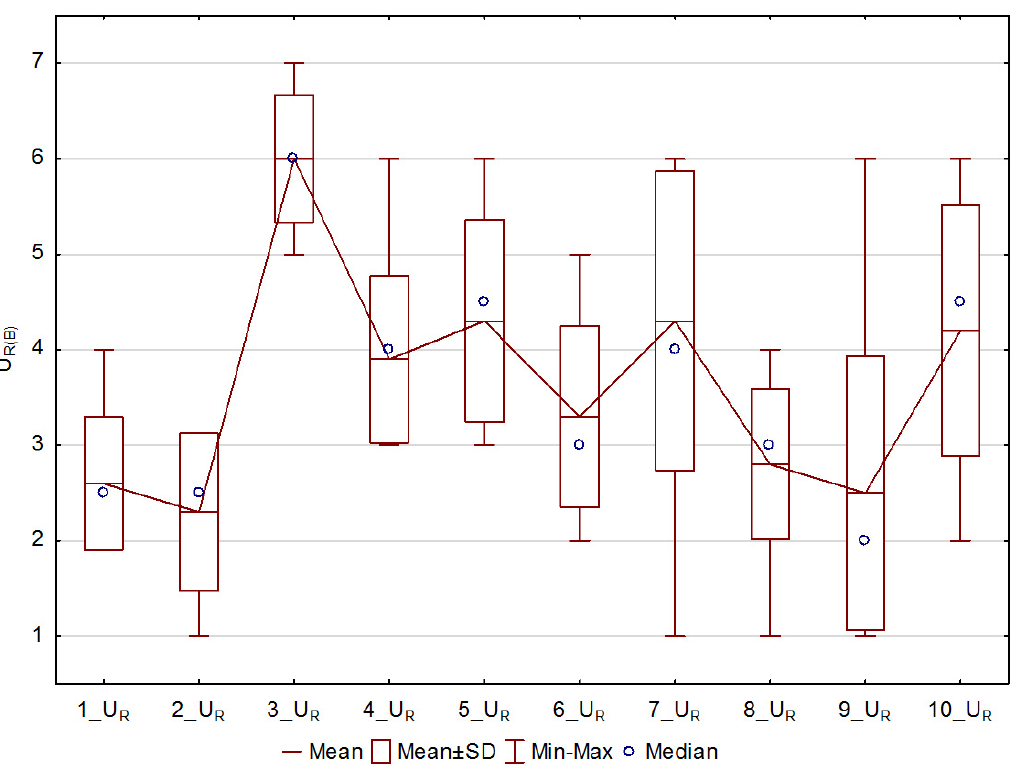
Figure 29. Corridor uniformity perception for group B.